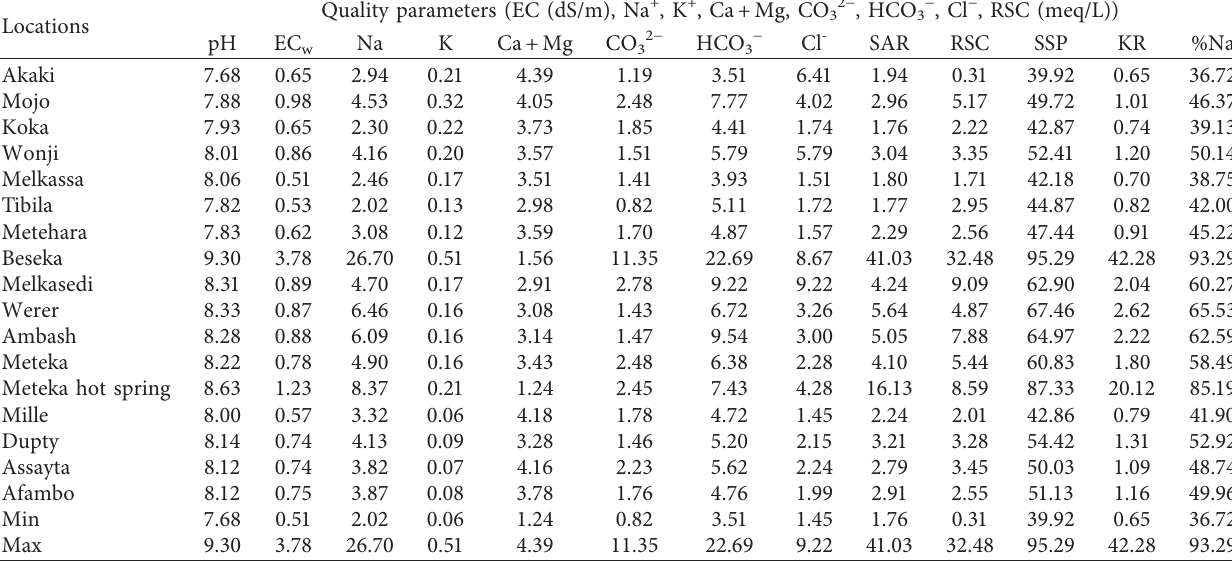
Table 10: Mean values of three-year irrigation water quality parameters of Awash River water. Locations